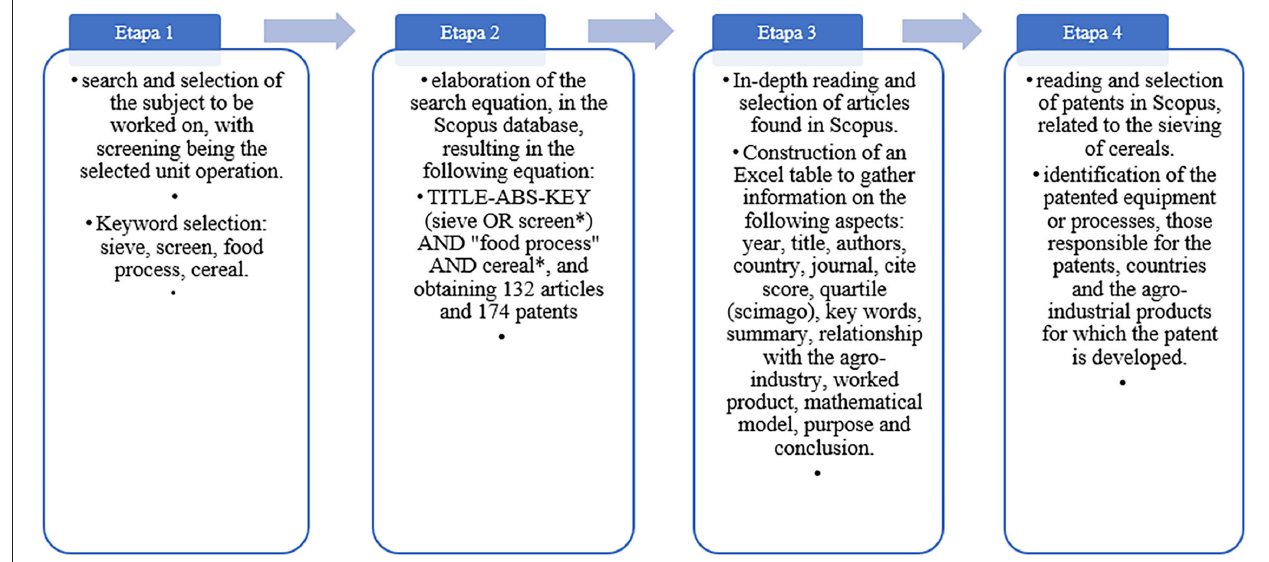
FIGURE 1 | Stages of paper creation. Source: The authors.